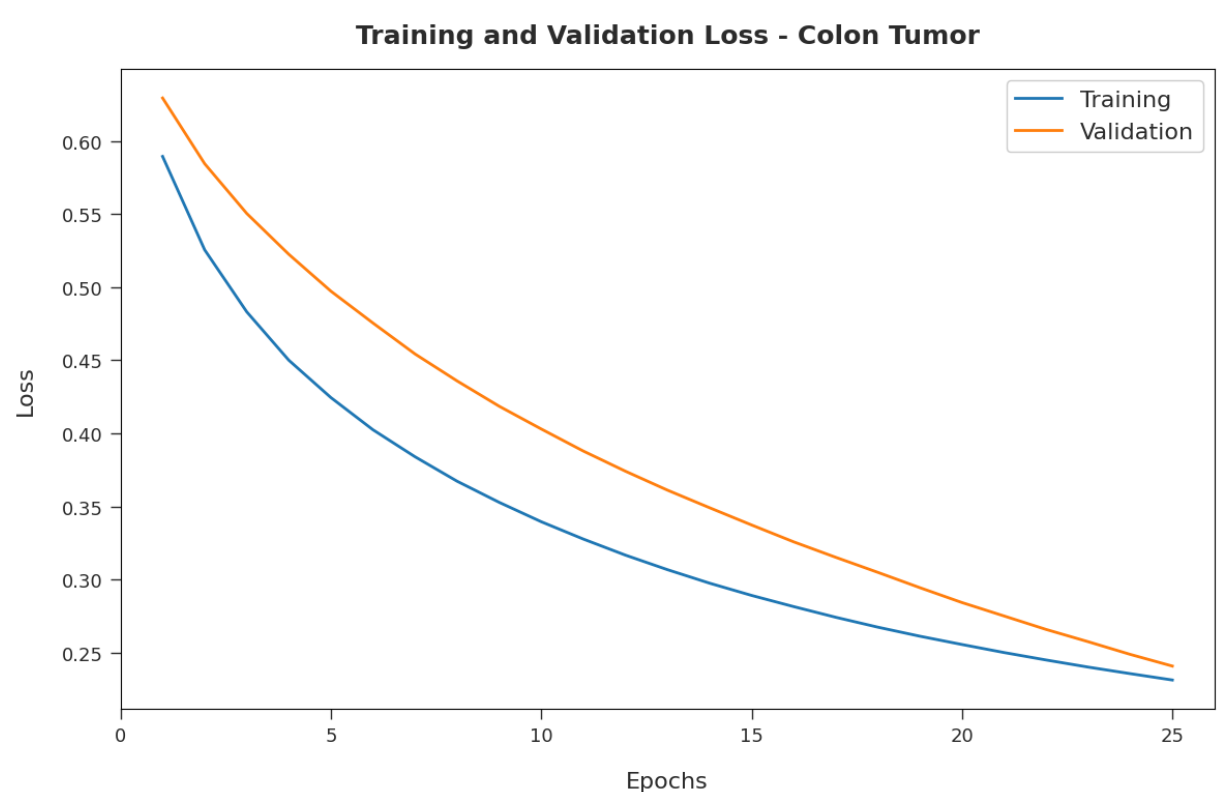
Figure 8. Loss analysis of RFODL-MGEC technique on colon tumor dataset.